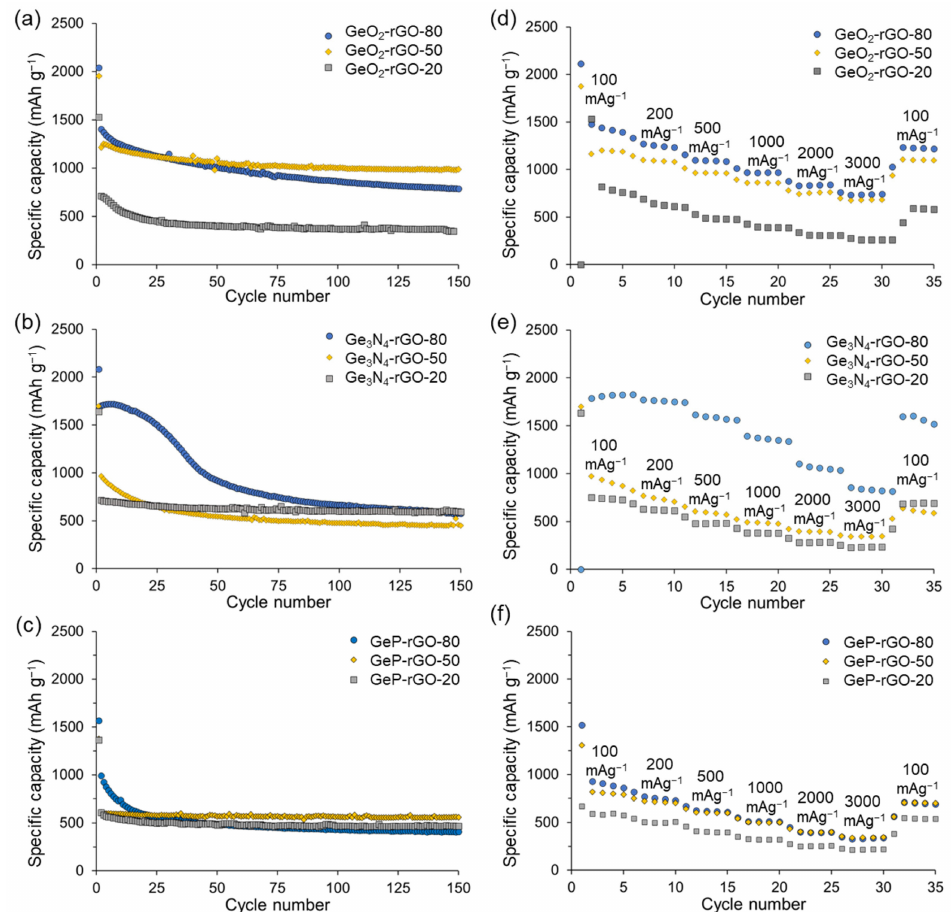
Figure 4. Cycling voltammetry of GeO 2 -rGO-80 ( a ), Ge 3 N 4 -rGO-80 ( b ), and GeP-rGO-80 ( c ) at 0.1 mV s − 1 . First and second charge − discharge curves for GeO 2 -rGO-80 ( d ), Ge 3 N 4 -rGO-80 ( e ), and GeP-rGO-80 ( f ) at 100 mA g − 1